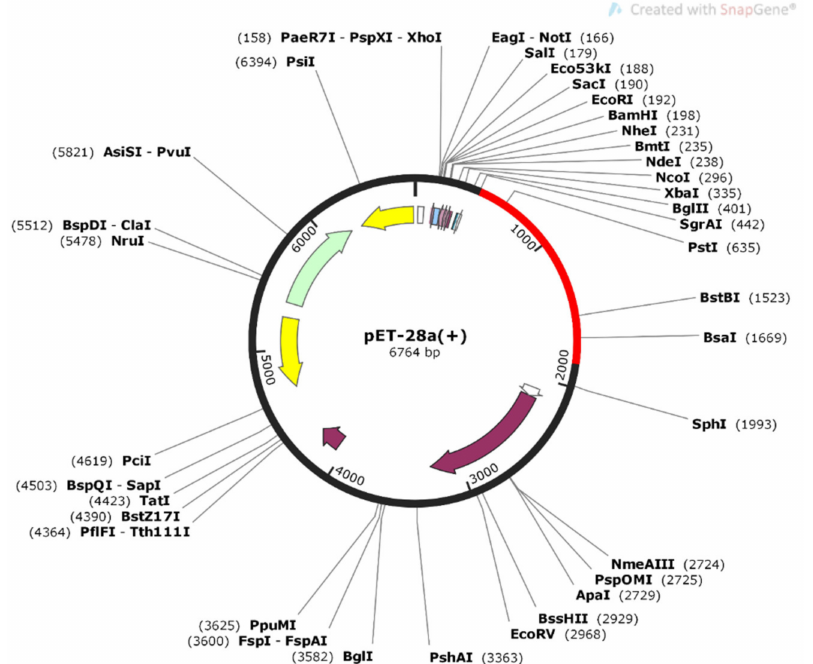
Figure 7. Codon optimization and in silico cloning of vaccine model. In silico restriction cloning of the multi-epitope vaccine sequence into the pET30a (+) expression vector using SnapGene soft- ware. The red part represents the vaccine’s gene coding region, and the black circle represents the vector